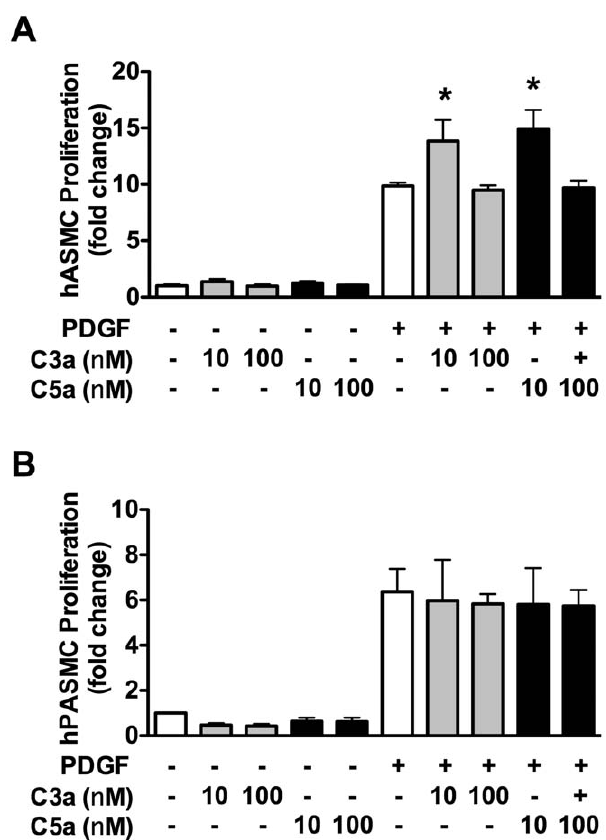
Figure 6. Complement C3a and C5a do not promote hPASMC proliferation. ( A ) hASMC and ( B ) hPASMC were treated with C3a or C5a with or without concurrent PDGF (10 ng/ml) stimulation and assessed for proliferation. Bars represent mean 6 SD of four individual experiments. * P , 0.05 vs. PDGF. n.s.=not significant.